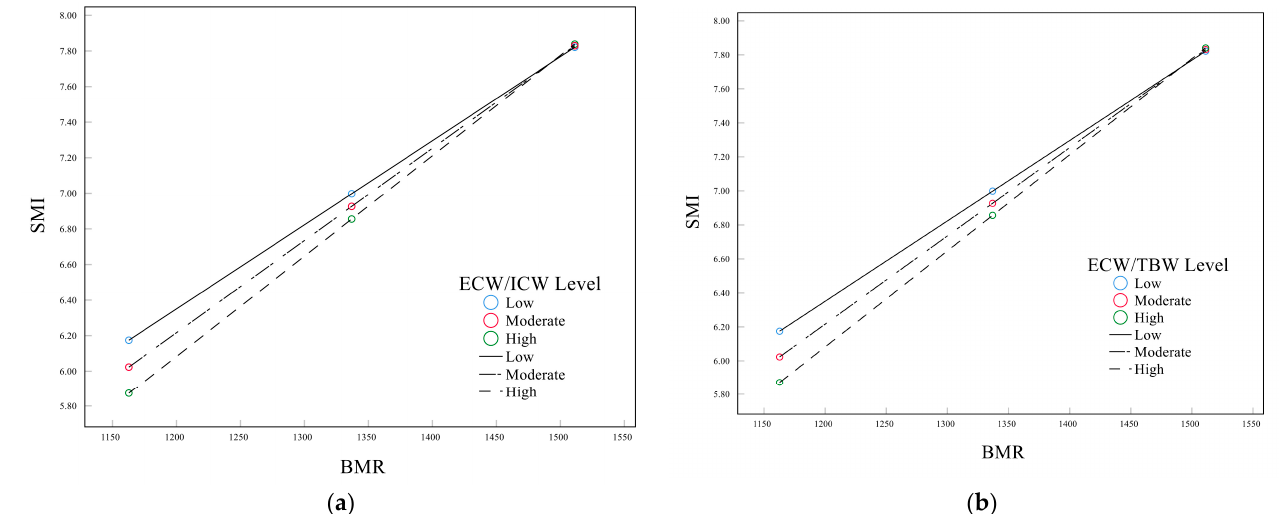
Figure 3. The moderating effects of BMR and body water distribution on SMI. ( a ) ECW/ICW; ( b ) ECW/TBW.